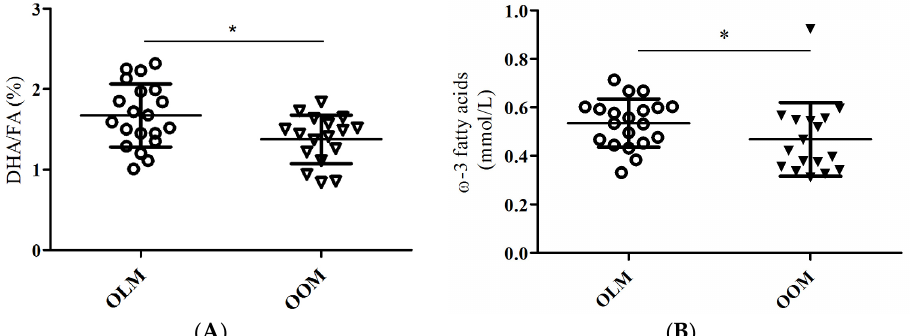
Figure 1. Differences in circulating docosahexaenoic acid to total fatty acid ratio (DHA/FA) percentages and ω‐ 3 FA concentrations in female offspring from lean mothers (OLM) or female offspring from obese mothers (OOM). ( A ) Circulating DHA/FA percentages. * p = 0.015 between OLM and OOM groups; ( B ) Circulating ω‐ 3 FA concentrations (FAw3). * p = 0.037 between OLM and OOM groups. Mean ± standard deviation (SD) are shown.